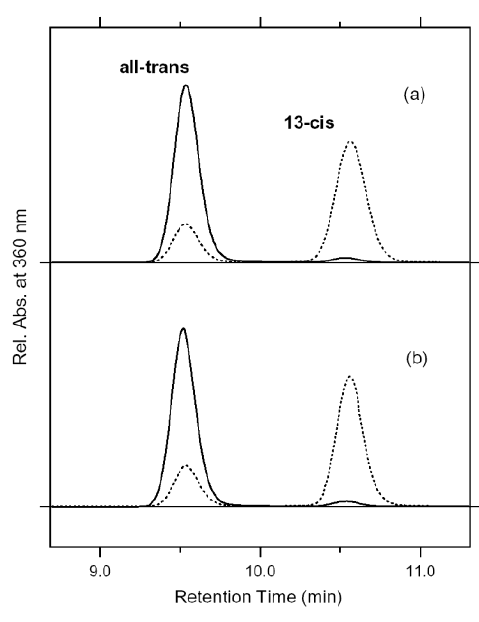
Figure 14. HPLC of chromophores extracted from ASR in DM micelles (a) and in PC liposomes (b). The detection beam was set at 360 nm. After the extraction, retinal oxime exists in 15- syn and 15- anti form. In the shown range of retention times, only the 15- syn form appears. We used area of both 15- syn and 15- anti forms for calculation of isomeric ratios. Dark-adapted ASR (solid lines) is in the all- trans form predominantly [AT-ASR; 95.5 ± 0.8% in (a) and 97.1 ± 0.1% in (b)], while light-adapted ASR (dotted lines) possesses more of the 13- cis form [13C-ASR; 78.1 ± 1.2% in (a) and 77.9 ± 1.7% in (b)]. This figure is reprinted with permission from Kawanabe et al. [59]. Copyright